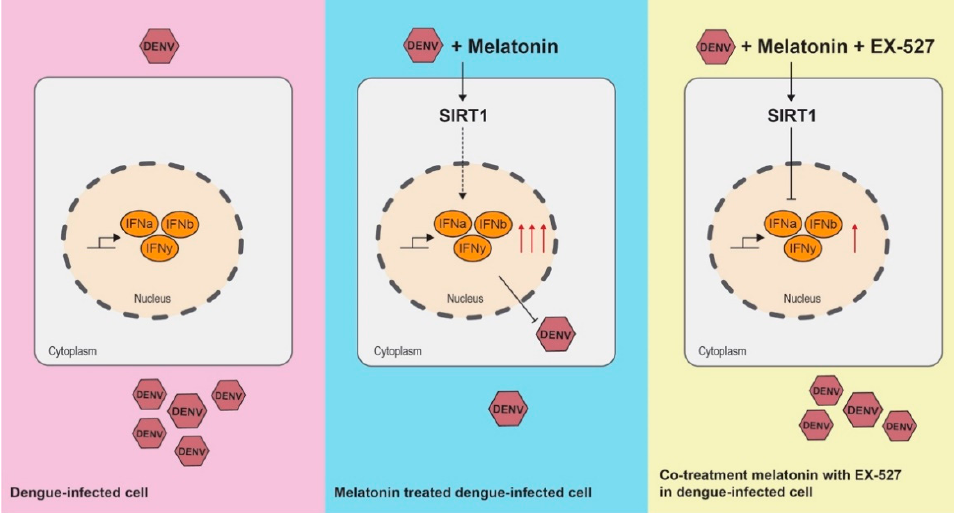
Figure 8. Proposed molecular mechanism of MEL in DENV-infected cells.